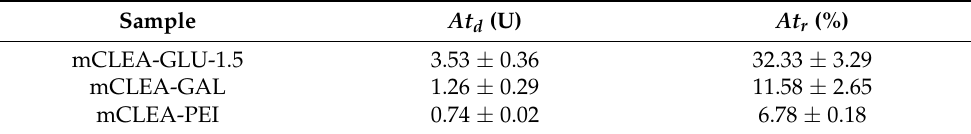
Table 3. Effect of the presence of galactose or PEI coating on magnetic cross-linked enzyme aggre- gates (mCLEAs) parameters of β -galactosidase: Immobilized enzyme activity ( At d ) and Recovered activity ( At r ).